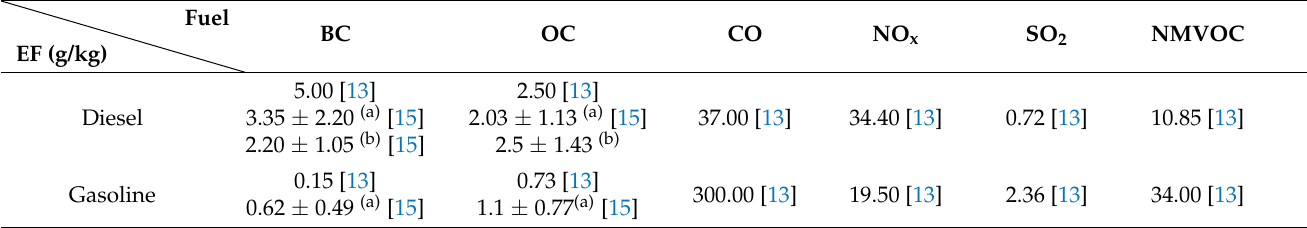
Table 1. Emissions factor (EF) of traffic sources for gasoline and diesel vehicle of different aerosols and gases from literature. Fuel BC OC CO NO x SO 2 NMVOC EF (g/kg) Diesel